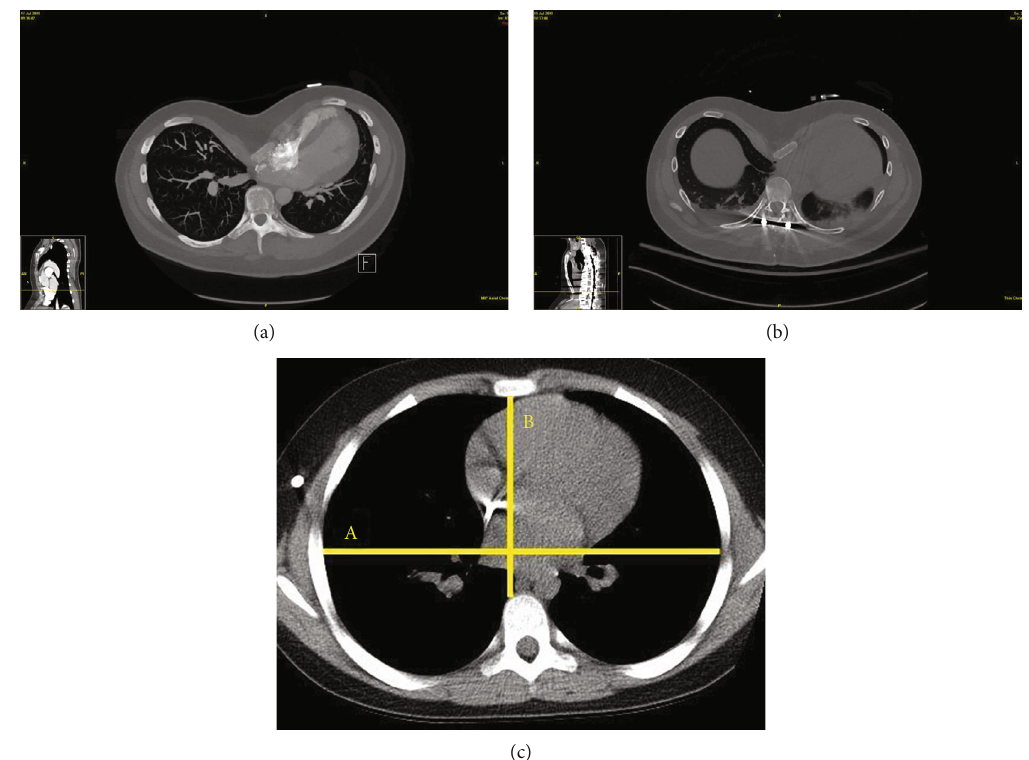
Figure 1: Comparison of preoperative and postoperative CT chest. Preoperative CT chest had a Haller index of 8.7. The anterior-posterior diameter minimum preoperatively was 3cm (a). Postoperative CT chest had a Haller index of 11.3 (b). The anterior-posterior diameter minimum postoperatively was 2.3cm. Example of a normal chest CT Haller index (c), with lines demonstrating measurements of the Haller index (ratio of A/B)